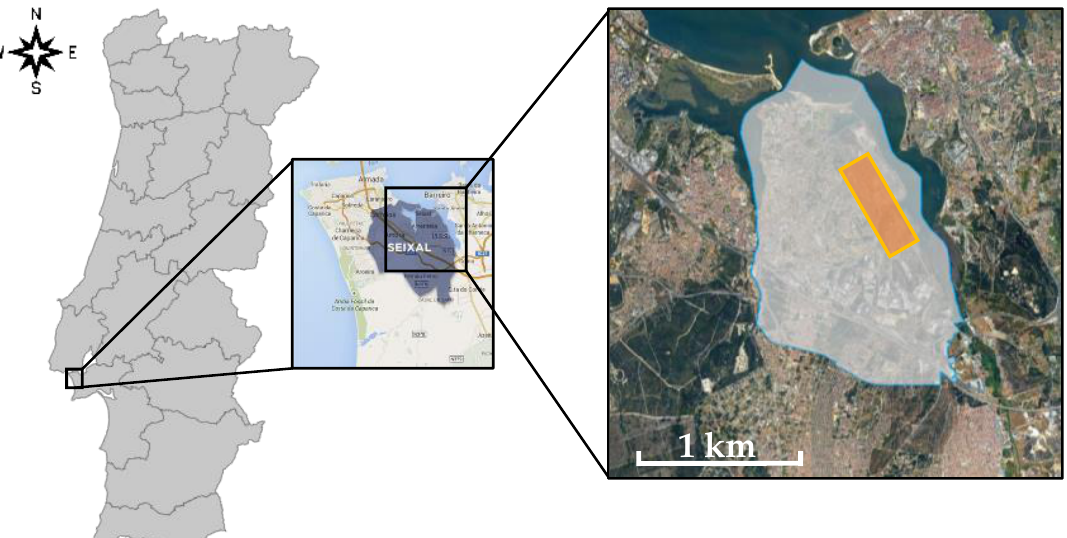
Figure 1. Location of the UFSAAPP area: (left) Framework of the study area (black rectangle) in Portugal mainland; (center) location of Seixal municipality highlighted; (right) location of UFSAAPP (whitish area with blue border represents the limits of the parish and orange represents the industrial area within it).